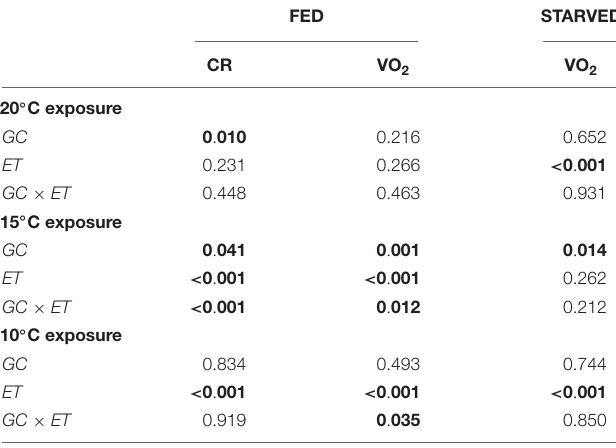
TABLE 2 | Two-way factor ANOVA (repeated measurements) showing the effects of growth condition (GC, F, or S) and exposure time (ET, days) on clearance rate (CR, L/h) and oxygen consumption (VO 2 , mLO 2 /h) in fed and starved mussels reared at 20 ◦ C.